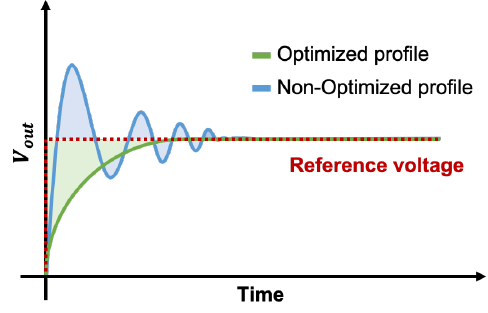
Figure 3. Example of output voltage profile